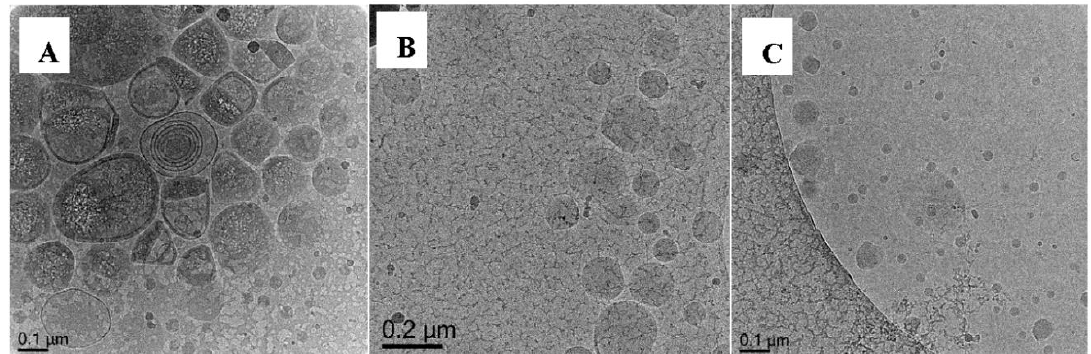
Figure 14. Cryo-TEM micrographs of Exp 13 ( A ), polymerization of (DODAB- Oligo 1 ) with MA/BA (10/1 wt); Exp 14 ( B ), polymerization of (DODAB- Oligo 1 ) with BA and Exp 15 ( C ), polymerization of (DODAB- Oligo 1 ) with BA/EGDA. Additional images in Figure S10 (Exp 13).